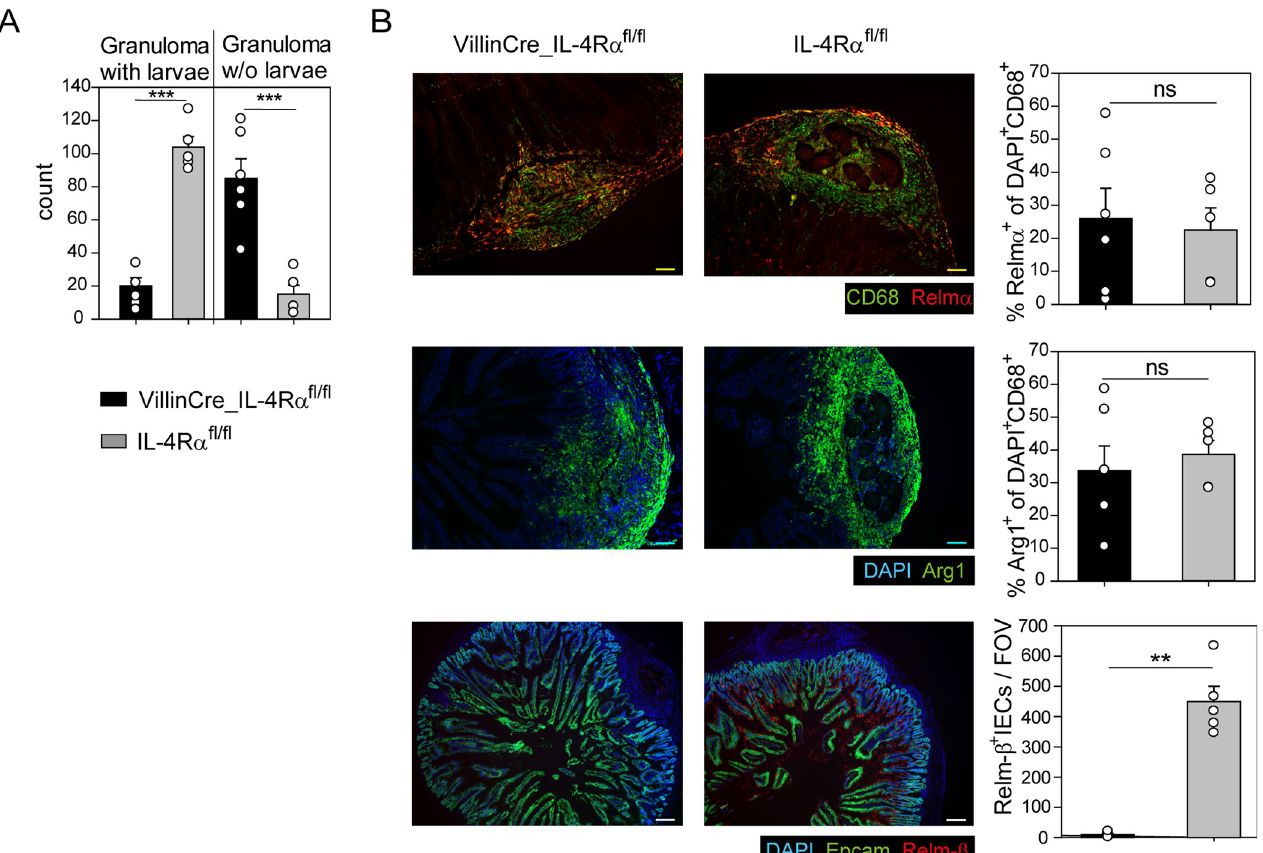
Fig 5. STAT6 signaling in IECs is required for efficient larval trapping. Mice with a specific deletion of the IL-4R α in intestinal epithelial cells (VillinCre_IL- 4R α fl/fl ) and their Cre - littermate controls (IL-4R α fl/fl ) were subjected to a secondary Hpb infection. A) Number of granuloma in the submucosa with or without (w/o) larvae counted on day 9 after secondary Hpb infection. B) Representative pictures and quantification of Relm- α (upper panel), Arg1 (middle panel) and Relm- β (lower panel) in histological small intestinal sections on day 9 after secondary Hpb infection. Quantification was calculated in Fiji (Relm- α and Arg1) or manually by counting Relm- β + IECs per field of view (FOV). Scale bar corresponds to 100 μ m (Relm- α and Arg1) or 200 μ m (Relm- β ). A-B) Mean + SEM of five to six mice per group from two independent experiments are displayed. Statistical significance was determined by Student’s t-Test. *** p < 0.001; ** p < 0.01; ns not